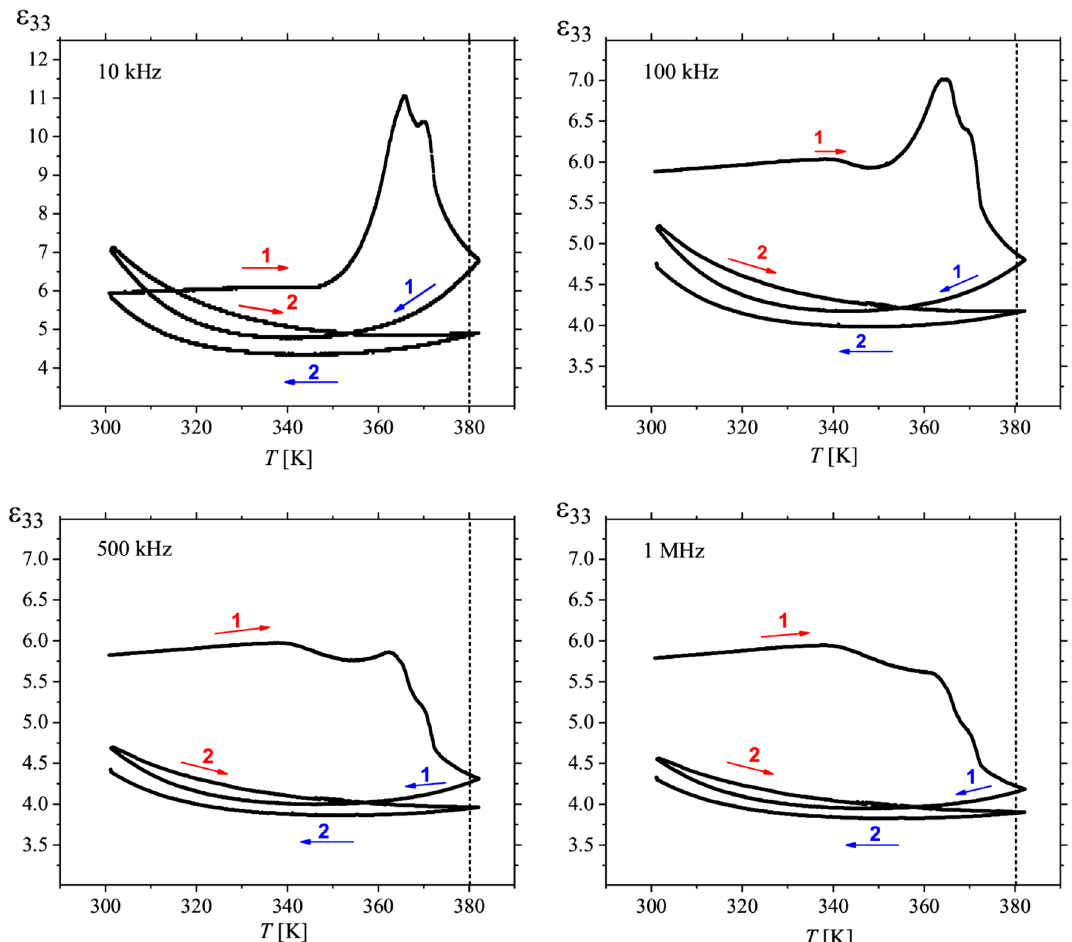
Figure 12. Temperature and frequency dependence of permittivity ε 33 , measured for the temperature rate of 0.4 K/min., demonstrating the transformation of struvite into dittmarite structure near 380 K. The fastest changes in all ε 33 ( T ) dependencies in the first cycle, marked in red 1, start above 350 K (for frequencies of 10 and 100 kHz) and 360 K (for frequencies of 500 kHz and 1 MHz). The permittivity ε 33 measured at frequencies below the piezoelectric resonances (10 kHz and 100 kHz) increases before struvite-dittmarite transformation at 380 K. The same behaviour reveals temperature changes of the d 33 , which rises before transformation point because its value depends directly on the ε 33. Thus, the data for low frequencies 10 kHz and 100 kHz corresponds well to temperature behaviour of the piezoelectric coefficients: d 33 and d 32 . Red and blue arrows indicate heating and cooling processes,